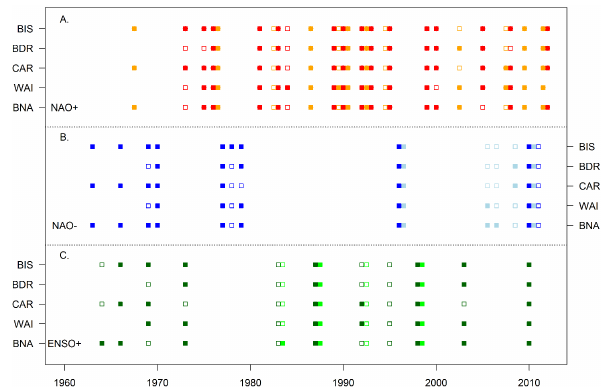
Figure 6. Summary of detected and missed fingerprints at all five US stations for (a) the NAO in its positive phase (winter red, spring orange), (b) the NAO in its negative phase (winter, blue; spring, light blue), and (c) ENSO in its warm phase (winter, red; spring, or- ange). Filled squares mark visible fingerprints, while open squares mark non-visible fingerprints.